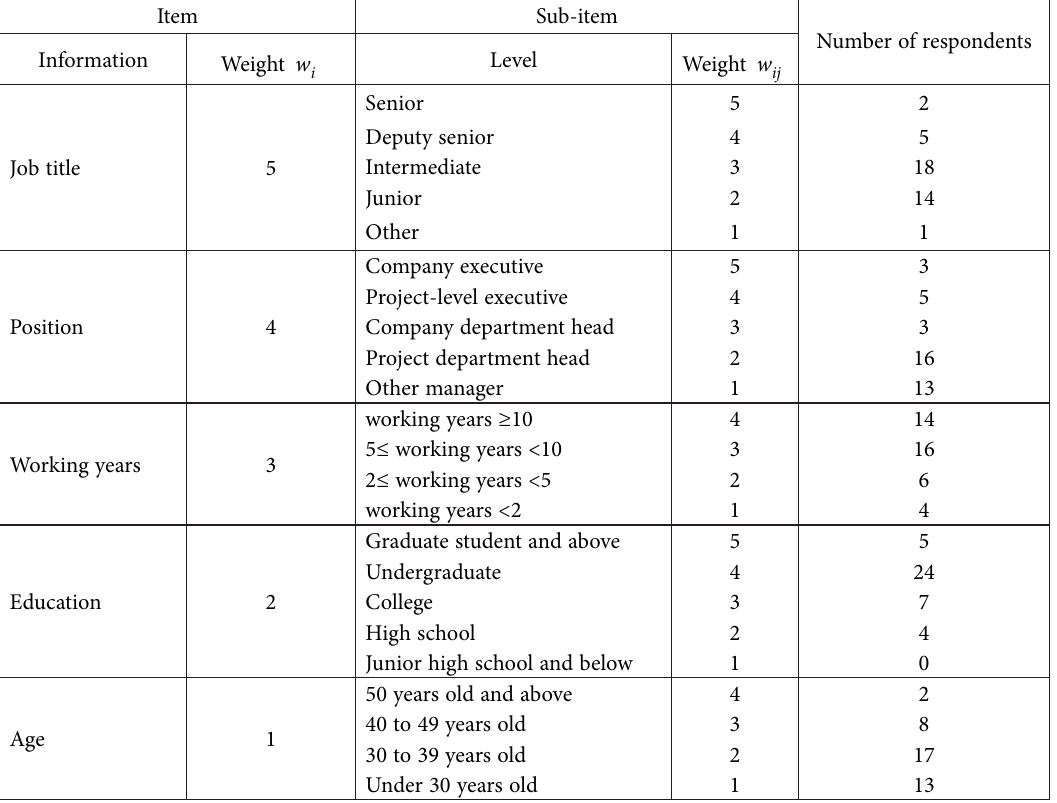
Table 4. Personal information of the respondents and corresponding weight values Item